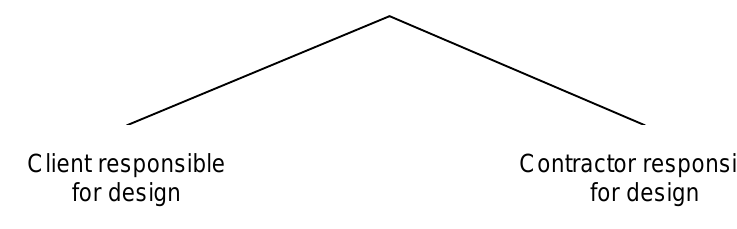
Figure 2: Step 2, Version 1: Who will do the design? (Source: